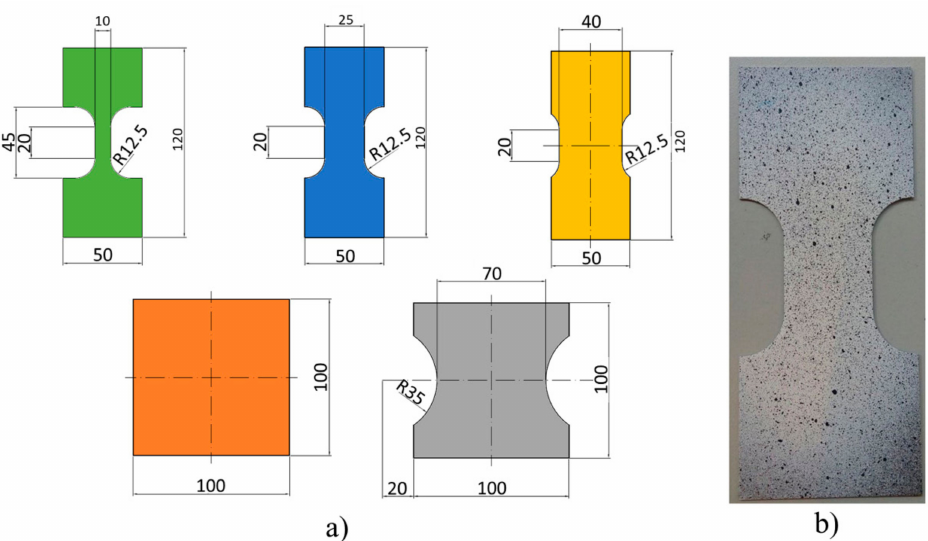
Figure 2. ( a ) Geometries for the Nakajima (all dimensions are in mm) and ( b ) sample painted with the stochastic pattern, intended to follow the deformation during the tests.